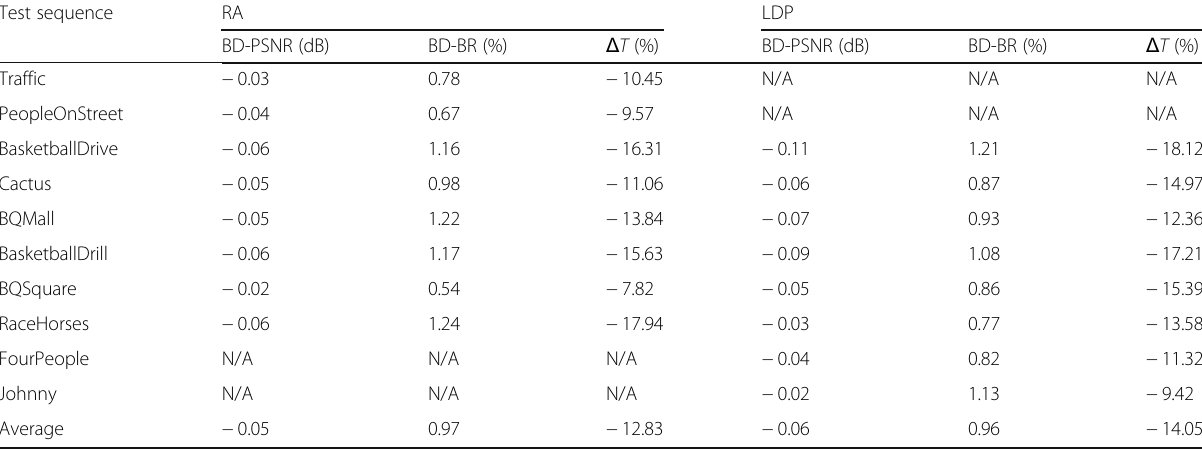
Table 2 Comparison between HM 14.0 (AMP off) and the original HM 14.0 (AMP on) Test sequence